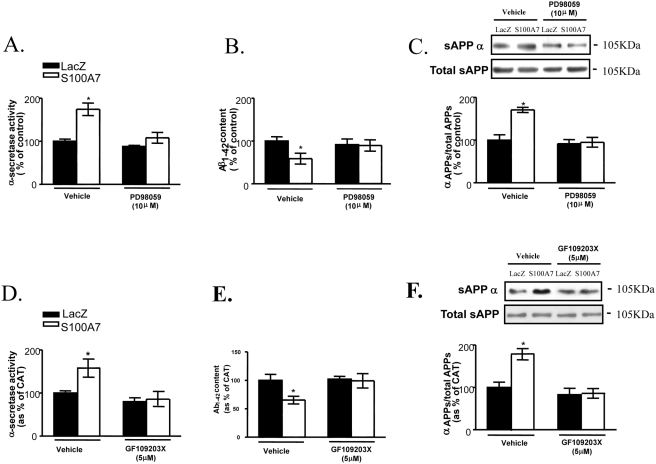
h-S100A7-mediated promotion of α-secretase activity and sAPPα secretion and decreased amyloid-beta1–42 level are prevented by p42/44MAPK and PKC signal-transduction inhibitors.In this study cortico-hippocampal neuron cultures derived from Tg2576 embryos were pre-incubated for 30 min with vehicle alone or with PD98059 (10 µM) (A–C) or with GF109203X (5 µM) (D–F). Following the preincubation time, the cells were infected with LacZ or h-S100A7 adenovirus for 24 h at 10 MOI. A, resulting cell lysates were analyzed for α-secretase activity. B, C, proteins released into the conditioned media were collected and analyzed for β-amyloid by ELISA or sAPP α and total sAPP by western blotting. Data represent mean±SEM of determinations made in two separate cultures; n = 3 to per culture; two-tailed Dunnett's t-test vs. control (vehicle treated): *P<0.05.